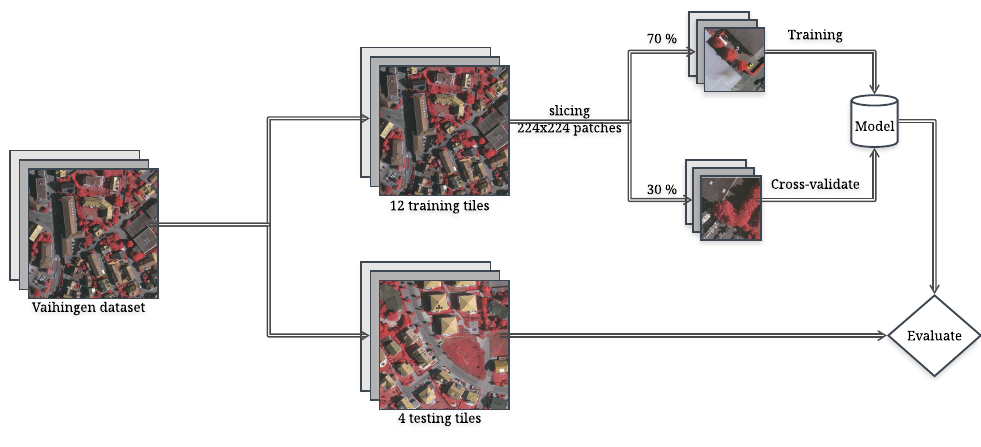
Figure 2. Experimental workflow of this research. The existing methods, as well as the proposed model, are trained and evaluated by 224 × 224 image patches extracted from original